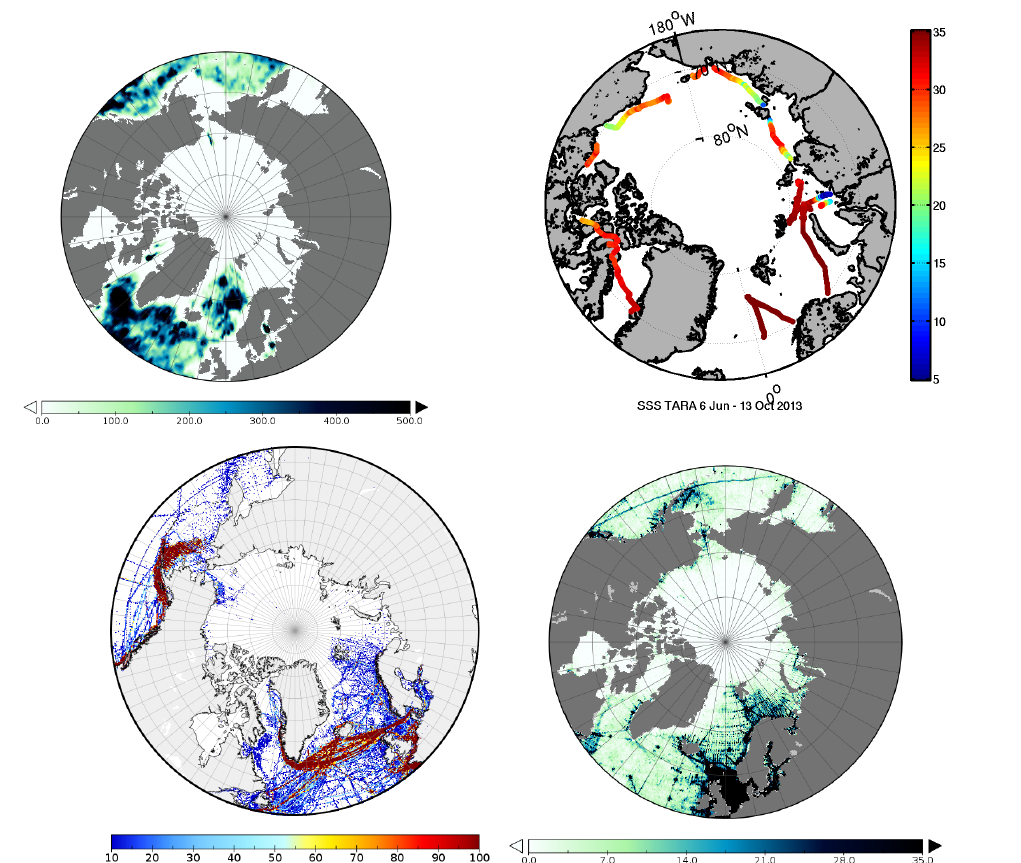
Figure 1. Number of measurements provided by Argo floats in the period of study 2011–2017 ( top-left ); salinity values (using the practical salinity scale) provided in the TARA campaign ( top-right ); number of SSS measurements provided by the TSG that have been used in this study for validation ( bottom-left ); and number of in situ measurements used in the computation of annual SSS climatology WOA ( bottom-right